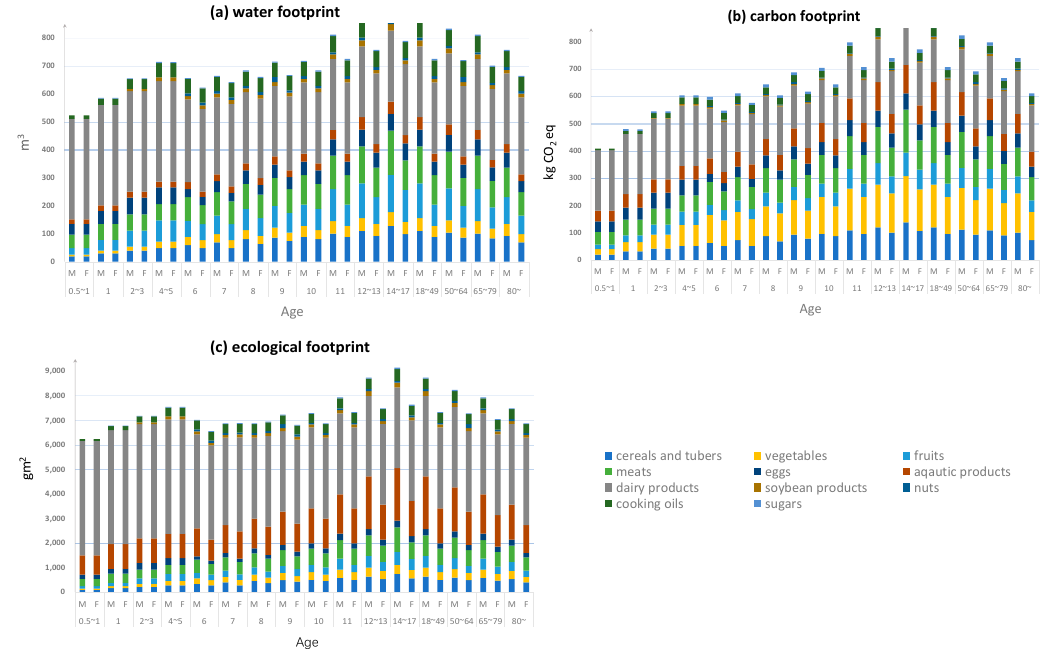
Figure 5. Footprint ( a ), carbon footprint ( b ), and ecological footprint ( c )of the food system in China .